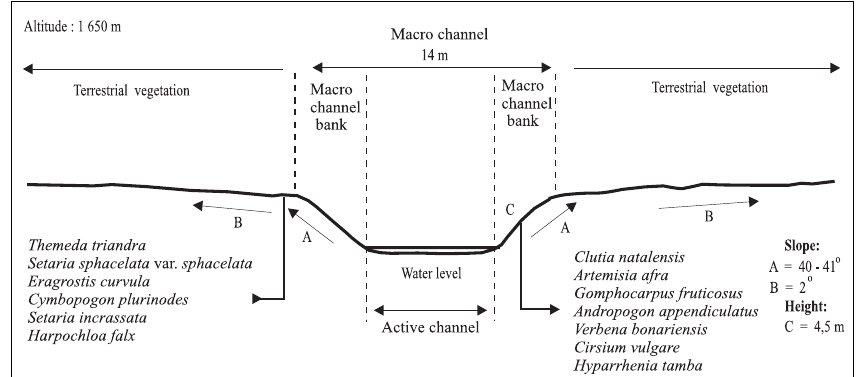
Fig. 4. River profile of the Clutia natalensis-Panicum dregeanum